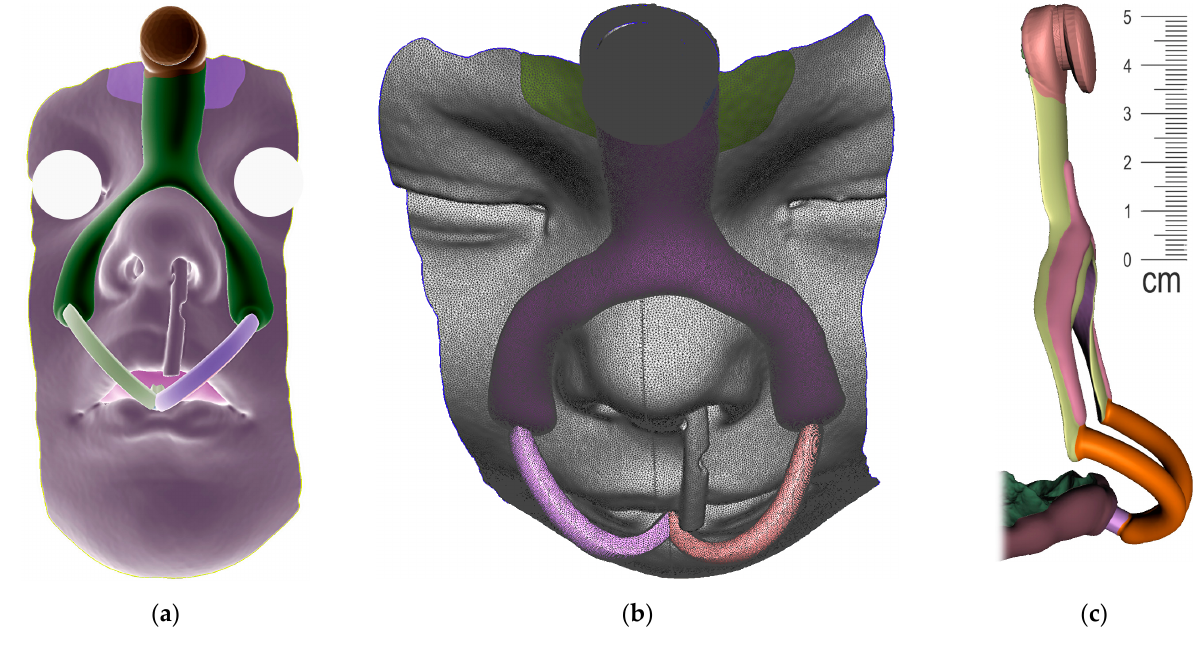
Figure 19. Result of Extraoral part of design based on CT and intraoral scan: ( a ) frontal view of extraoral part of appliance with button on the forehead intended for elastic cap providing retention, complementary nasal part distributing the pressure on wider surface and labial bows ended with spherical joint connecting to Alveolar part of appliance; ( b ) view of composite bows leaving the surface part circumventing the highly movable part of the lips; ( c ) lateral view of the final 3D personalized appliance suitable for 3D printing from Dental LT Clear V2 (Formlabs, Somerville, MA, USA).